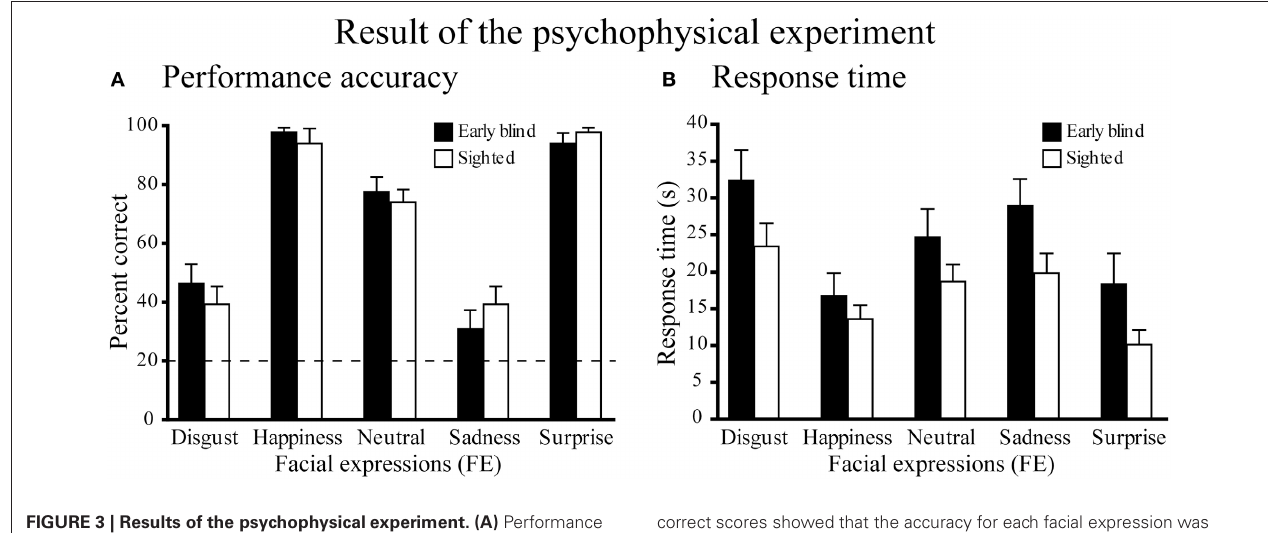
correct scores showed that the accuracy for each facial expression was significantly above chance ( P -values < 0 . 01). (B) Response time. The same two-way ANOVA on the response time produced a significant main effect of expression ( P < 0 . 001), but neither the main effect of group nor the interaction between expression and group were significant ( P -values > 0 . 1). Data are presented as the mean ± SEM of 14 subjects for each